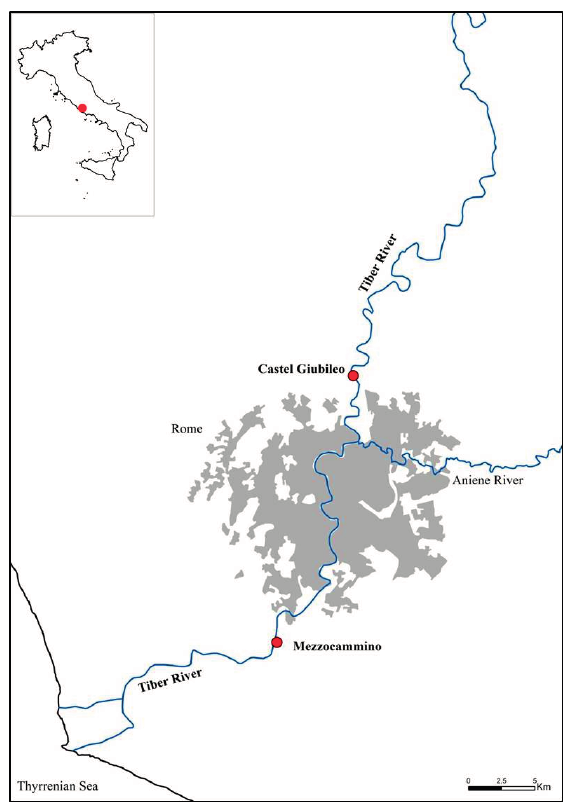
Figure 1. Localization of sampling sites (red dots) and the urbanized region of Rome (gray